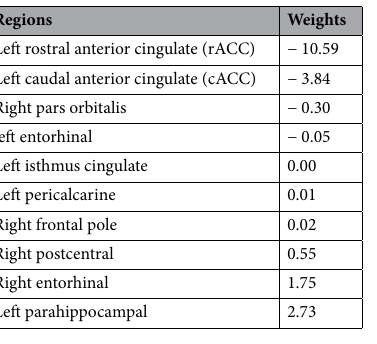
Table 1. Mean weights for nested cross-validation best estimator (unbiased model). ‘−/ + ’ sign indicates a negative/positive correlation of the corresponding region with personal optimism bias (POB).